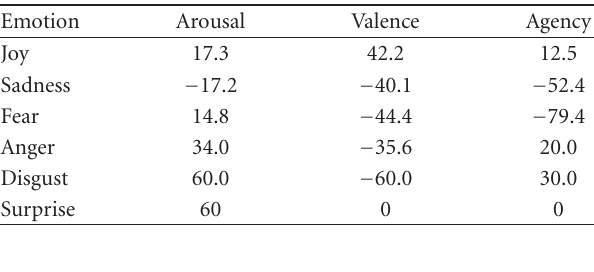
Table 3: Dimensional values for standard emotions.